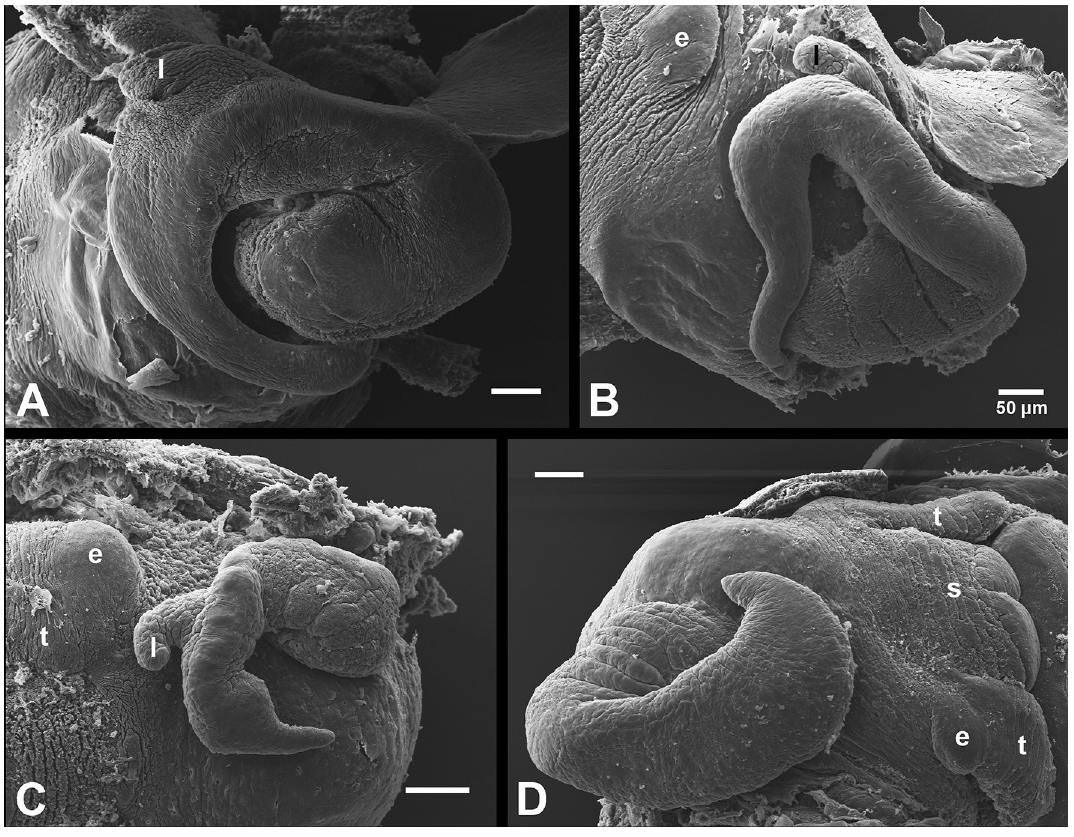
Fig. 11. Penis. SEM photographs. A . Opacuincola lisannea sp. nov. (from type locality). B . Op. gretathunbergae sp. nov. C . Op. mete kahurangi subsp. nov. D . Obtusopyrgus farri sp. nov. Abbreviations: e = eye; l = penial lobe; s = snout; t =